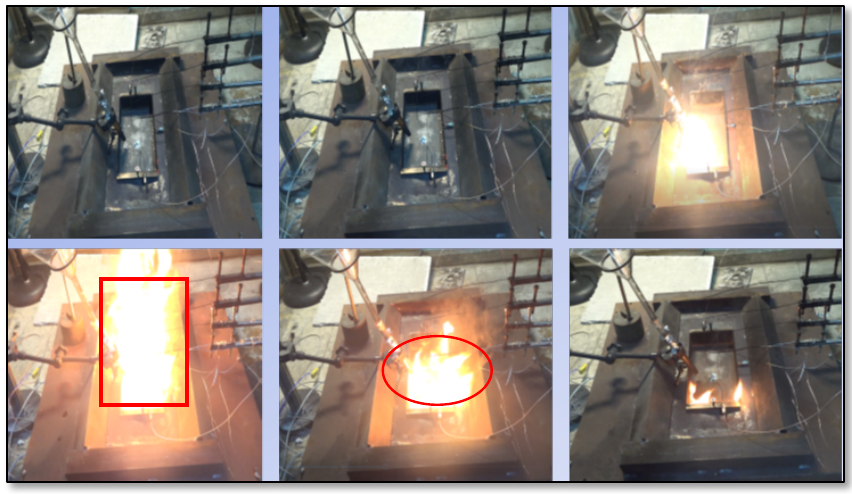
Fig. 2. Hot wall fire diagram of leaking